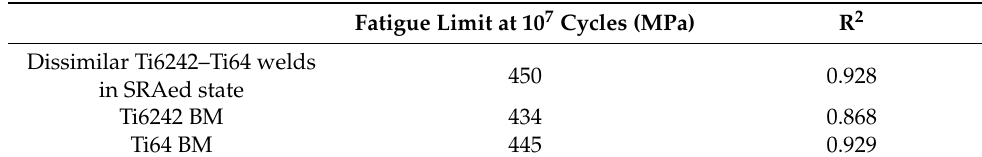
Table 4. Comparison of the fatigue limit of dissimilar Ti6242–Ti64 welds with that of the Ti6242 and Ti64 BMs at 107 cycles.